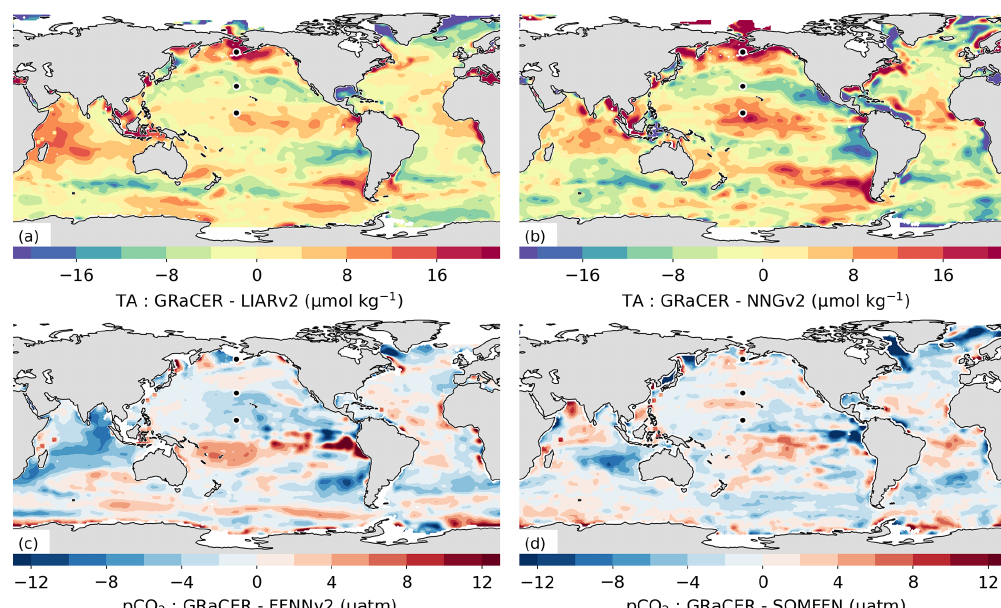
Figure 8. A comparison of the mean differences between TA (a, b) and p CO 2 (c, d) for OceanSODA-ETHZ and other published meth- ods: (a) LIARv2, (b) NNGv2, (c) CMEMS-FFNNv2, and (d) MPI-SOMFFN. The markers in the North Pacific show the locations used in the comparison of the climatology in Fig. 11.